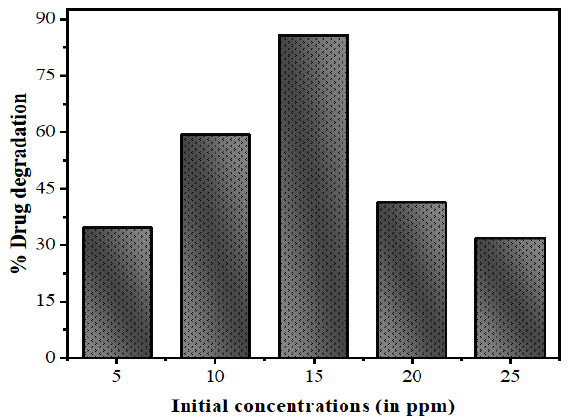
Figure 14. Effect of variation of the initial concentration of drug NOFX on the photocatalytic degradation under optimal conditions (25 mL of drug NOFX, pH 10, 60 min irradiation, 60 mgs QDs).